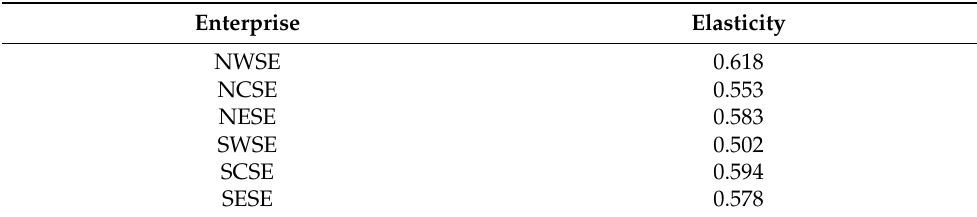
Table 11. SIZE elasticities (slopes) of leverage for the Bulgarian forest